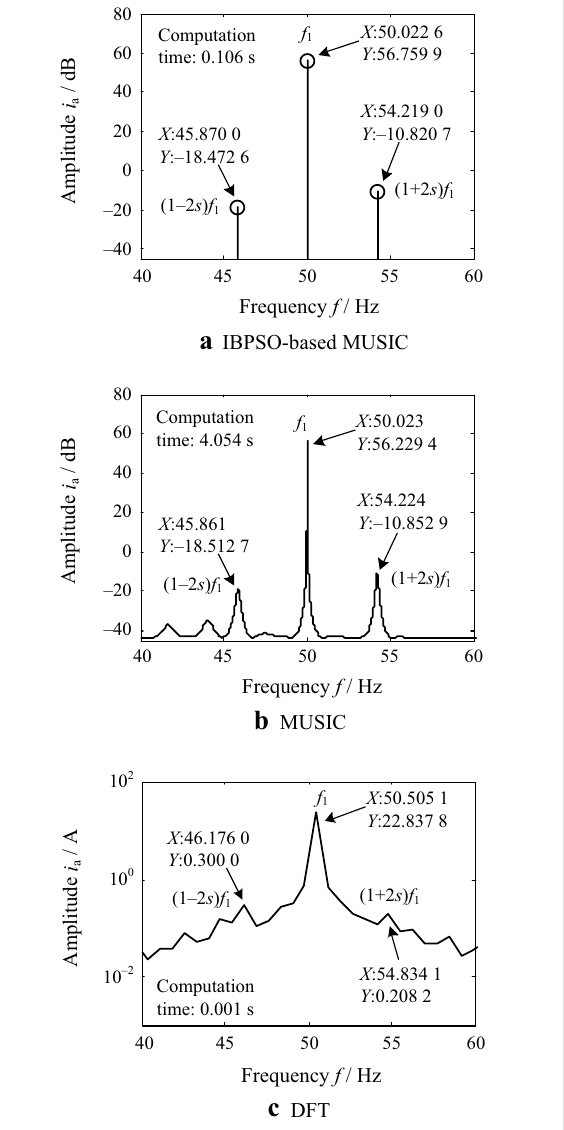
Figure 7 Spectrum analysis results of three algorithms at full‑load